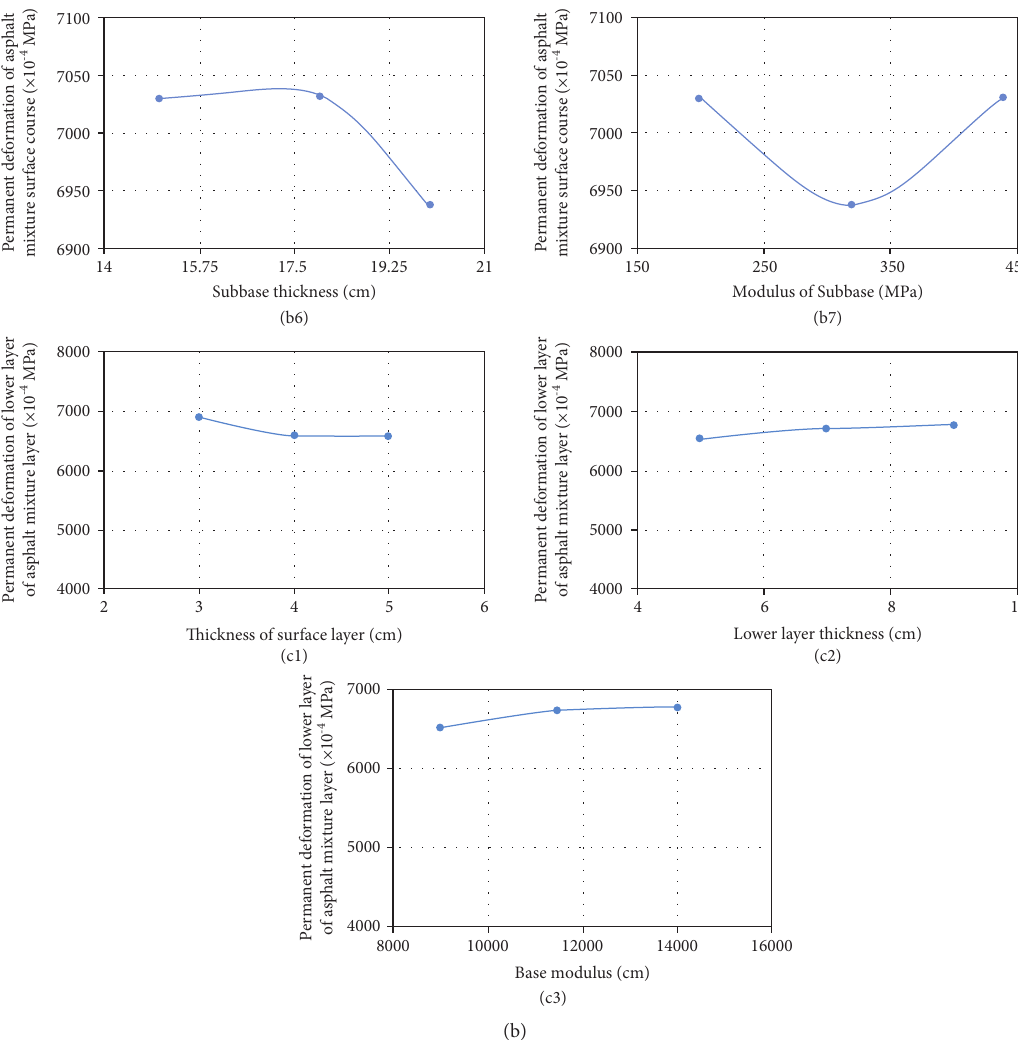
Figure 5: Trend chart of working condition